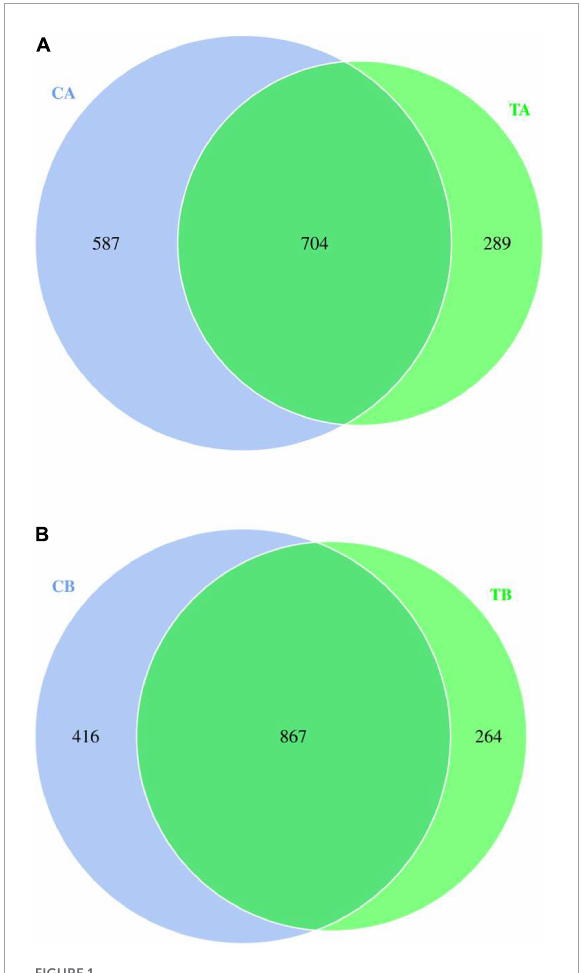
FIGURE1 Venn graph for intestinal microbiota of piglets weaned on day 14 of age (14W) and day 28 of age (28W) at different sampling timepoints [day 28 of age (A) ; day 70 of age (B) ]. CA group was defined as the sample from piglets in 28W group at the timepoint of day 28 of age. TA group was defined as the sample from piglets in 14W group at the timepoint of day 28 of age (A) . CB group was defined as the sample from piglets in 28W group at the timepoint of day 70 of age. TB group was defined as the sample from piglets in 14W group at the timepoint of day 70 of age (B)